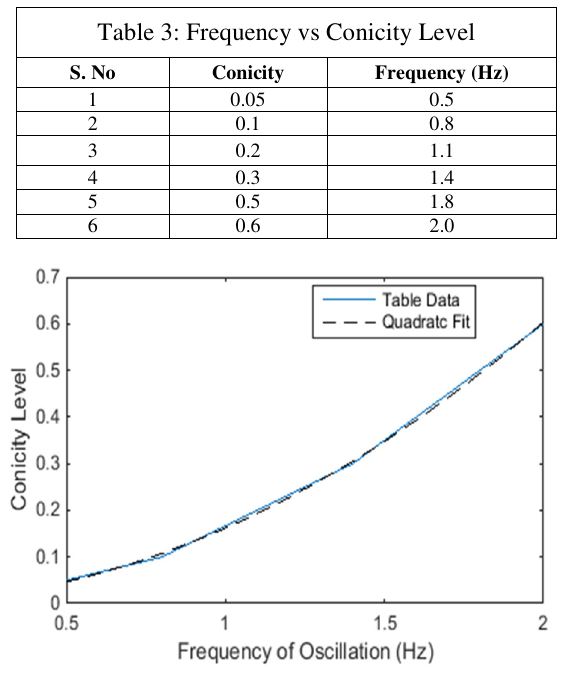
Fig. 8: Conicity Level vs Frequency of Oscillation